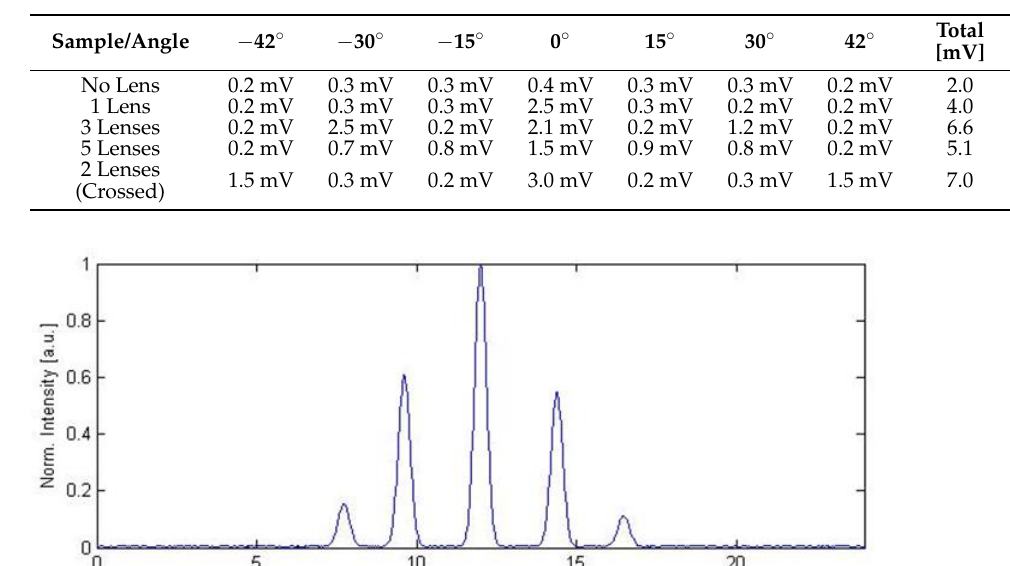
Figure 17. Output of the PV cell at different angles of incident of the light for each configuration of the holographic lenses. Table 5. Voltage measured at the PV cell for each multiplexed configuration (three, five lenses and crossed lenses).